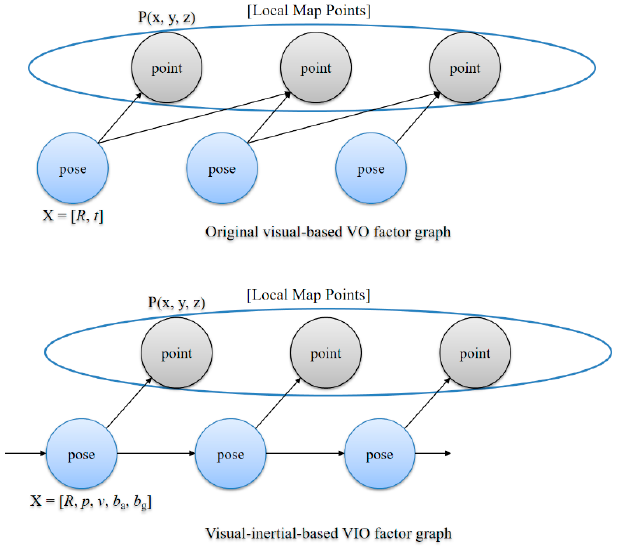
Figure 5. Comparison of the original visual-based VO factor graph and visual–inertial-based VIO factor graph.